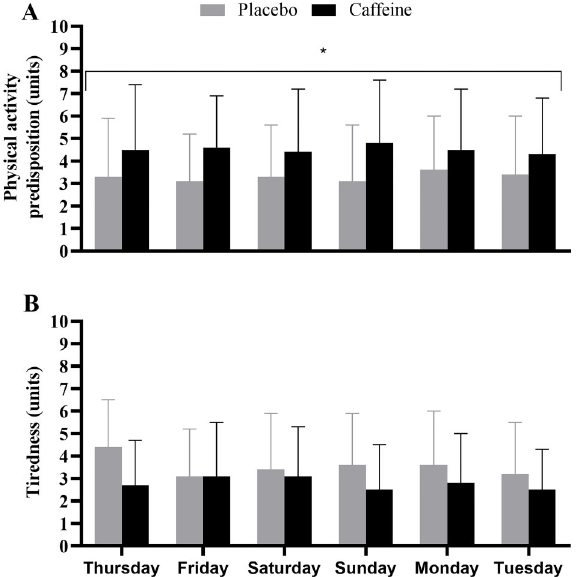
Figure 1. Self-reported physical activity predisposition ( A ) and tiredness ( B ). Data are reported as means ± SD for